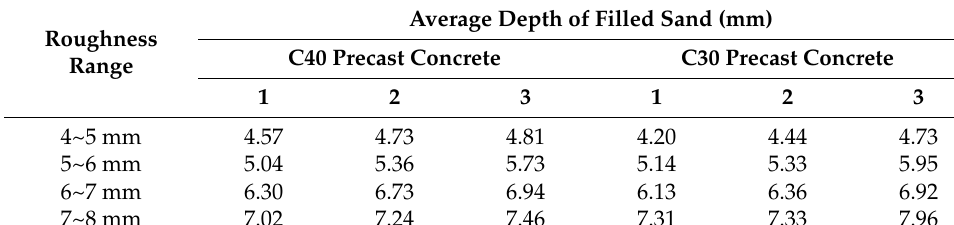
Table 9. Test results of roughness of washed rough surface of precast concrete.